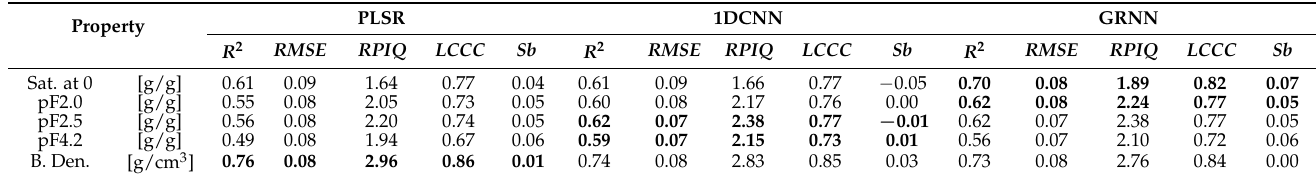
Table 2. Summary of model validation statistics for the “Water” group. The best prediction result for particular variables is marked in bold.